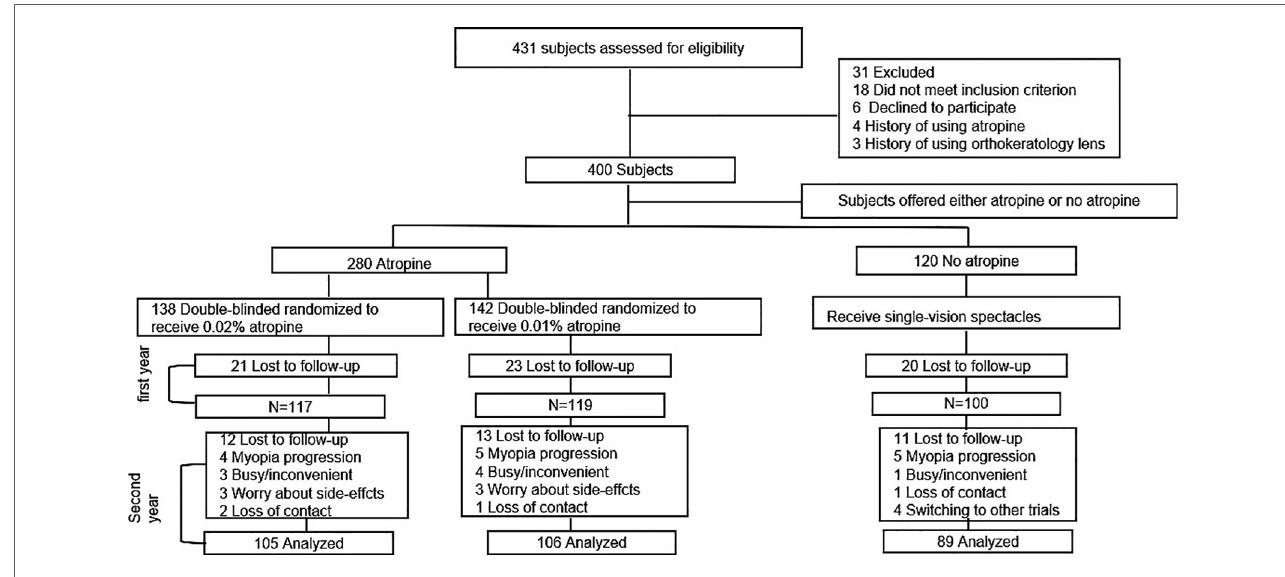
FIGURE 1 Subject recruitment and randomization fl